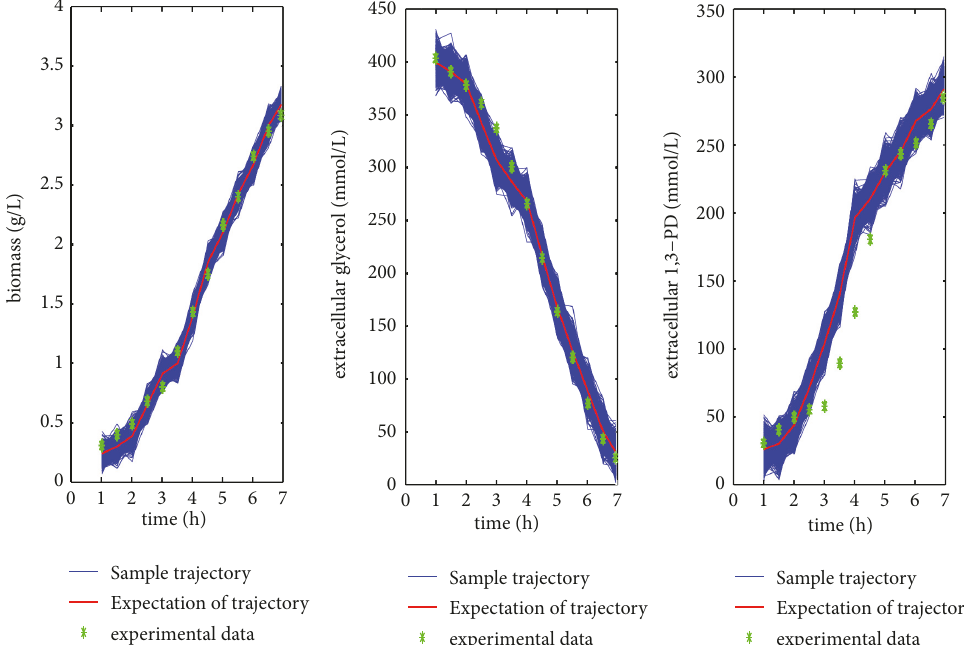
Figure 1: The results of initial glycerol concentration of 418.2609 𝑚𝑚𝑜𝑙/𝐿 and biomass concentration of 0.102 𝑔/𝐿 with 1000 sample trajectories.